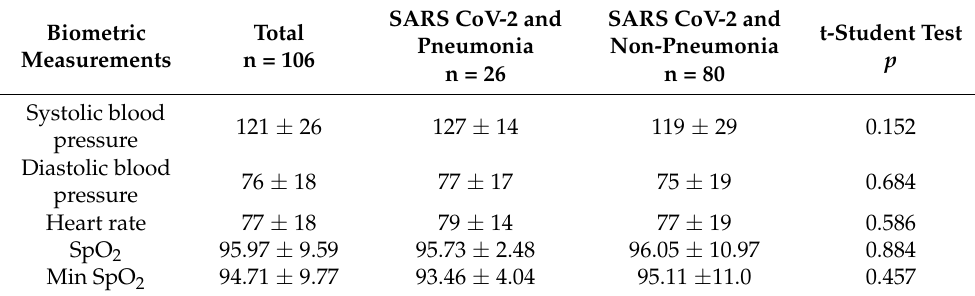
Table 7. Mean values of biometric parameters according to pneumonia.